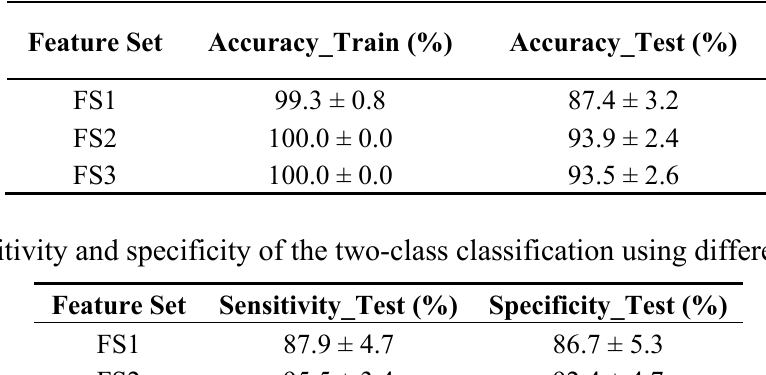
Table 4. System performance of the two-class classification using different feature sets.